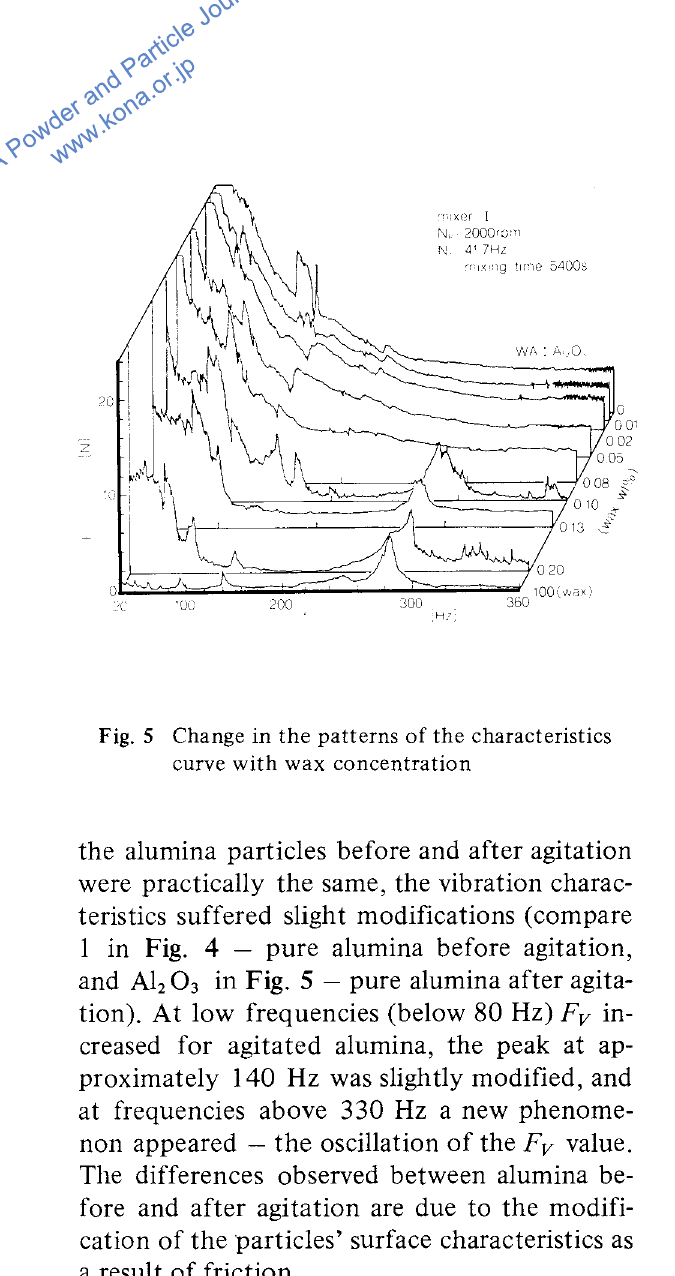
Fig. 6(ii) Relationships between M and /for different combinations of powder using mixer I: (ii) alumina-wax-Boron · Nitride